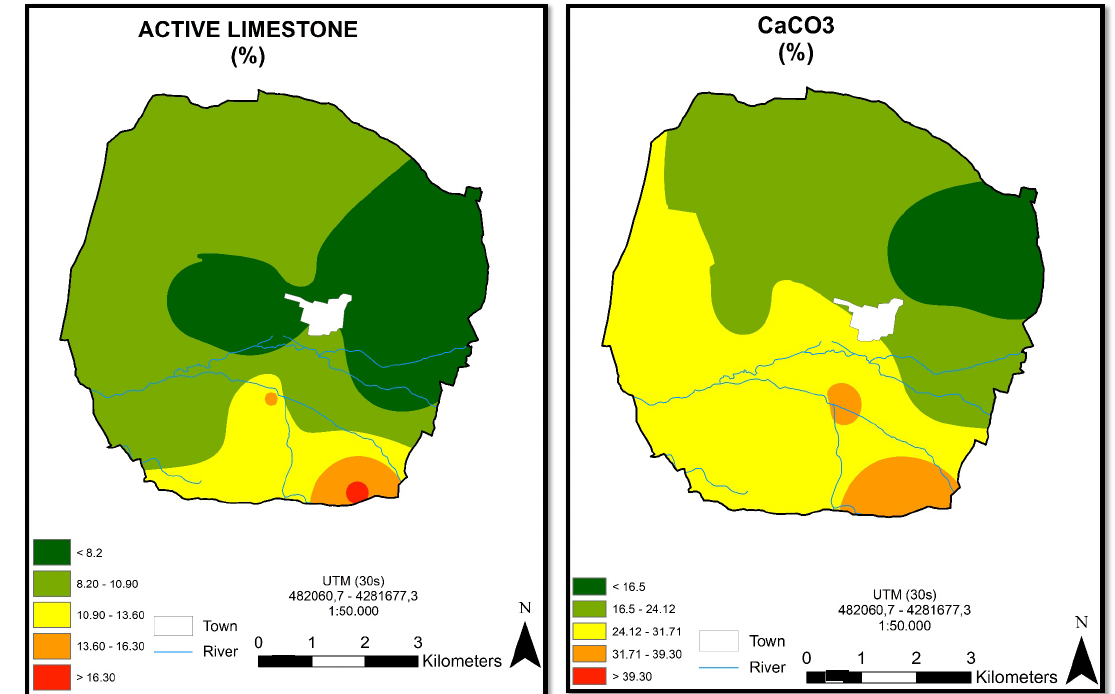
Figure 3. Spatial variability of active limestone ( a ) and calcium carbonate contents ( b